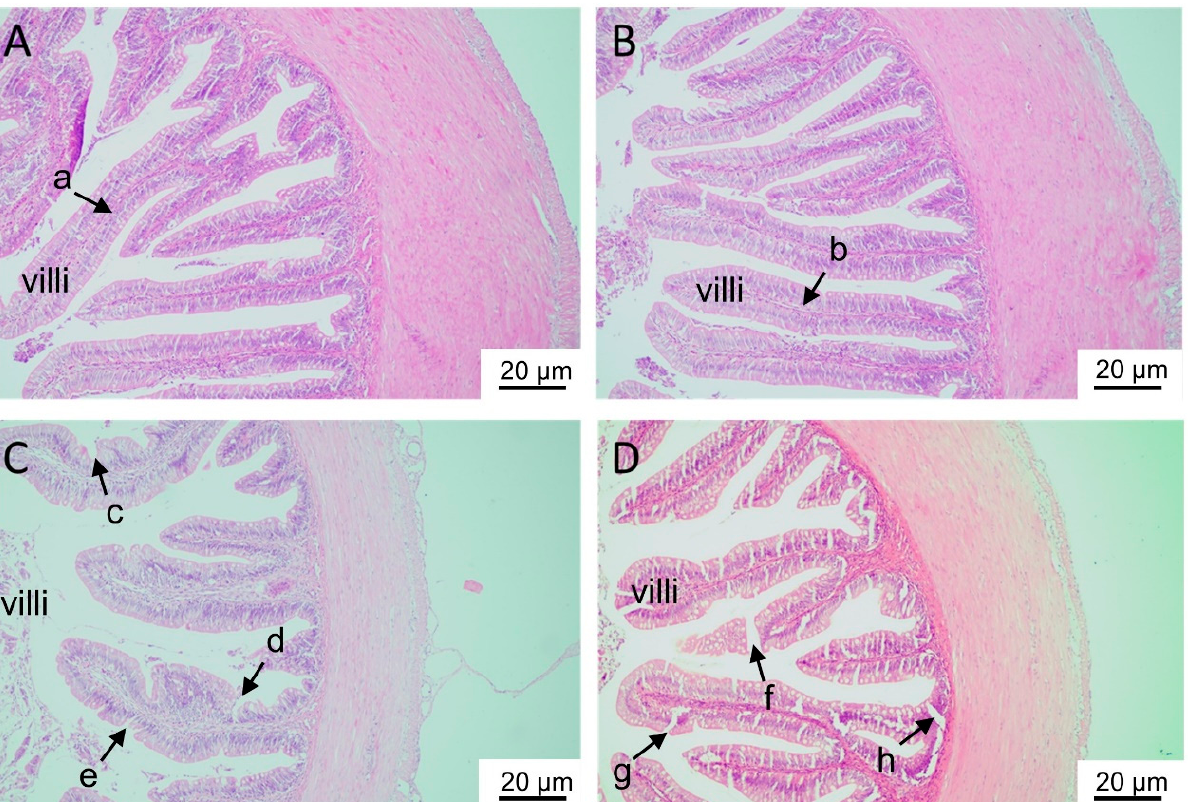
Figure 2. Histological analyses of the intestinal tissues of yellow catfish fed four experimental diets. ( A ) The control. ( B ) 50 mg/kg nano-ZnO group. ( C ) 100 mg/kg nano-ZnO group. ( D ) 100 mg/kg nano-ZnO + TPEN group. In ( A , B ), the intestinal villi were complete, full, and intact (arrows a and b). In ( C , D ), the villi showed injury, notching and vacuoles (arrows c–h).